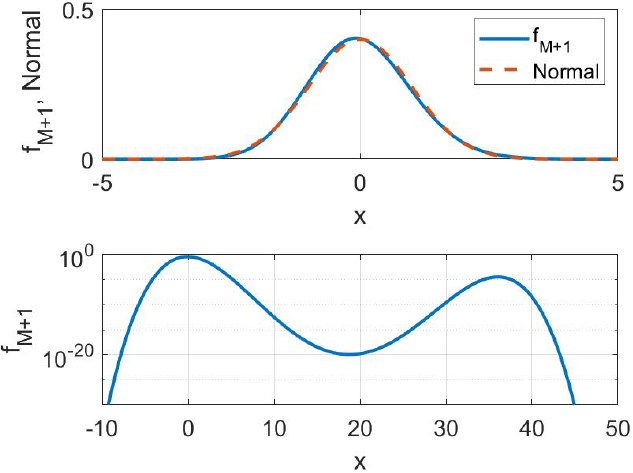
Figure 2. Hamburger case, M = 3. f M + 1 ( ˜ µ M + 1 ) and Normal (top) . f M + 1 ( ˜ µ M + 1 ) in logarithmic scale